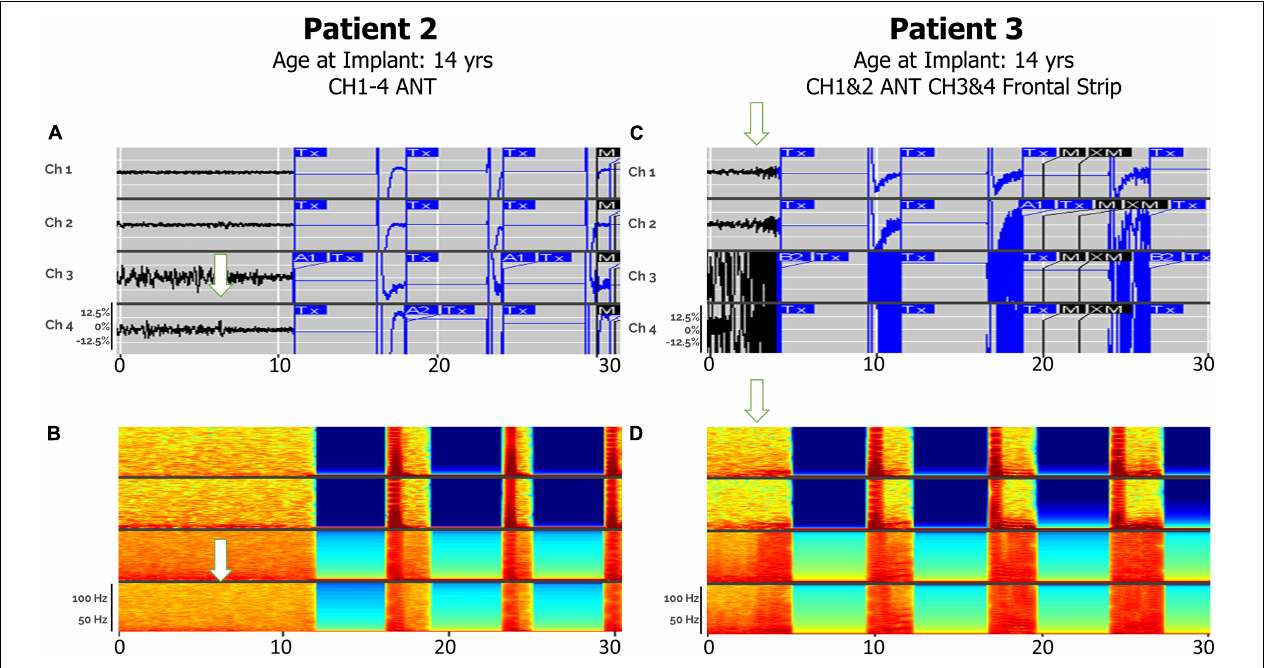
FIGURE 3 | Electrographic seizures detected in ANT (Anterior Thalamic Nucleus), with and without cortical strip leads, recorded by the RNS system. Arrows denote seizure onsets. (A) An example of a clinical seizure in Patient 2, stored in the NeuroPace Patient Data Management System (PDMS) over a 30-s window with bilateral ANT leads, left channels (Ch 1. L-ANT1–L-ANT2; Ch 2. L-ANT3–L-ANT4) and right channels (Ch 3. R-ANT1–R-ANT2; Ch 4. R-ANT3–R-ANT4). (B) Spectrogram of identical epoch. (C) An example of an electroclinical generalized tonic-clonic seizure in Patient 3 stored in PDMS over a 30-s window, with a right ANT depth lead and a right anterior prefrontal cortical strip (Anc) lead. Ch 1. R-ANT1–R-ANT2; Ch 2. R-ANT3–R-ANT4; Ch 3. R-Anc1–R-Anc2; Ch 4. R-Anc3–R-Anc4. (D) Spectrogram of identical epoch. Tx, therapy; M, magnet swipe; A1, Pattern A, 1st detector; B2, Pattern B, 2nd detector; M, magnet; XM, magnet